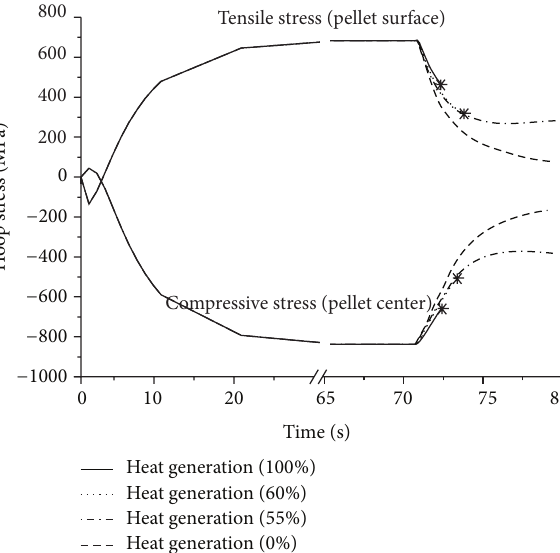
Figure 13: Compressive and tensile stresses changes at pellet center and outer surface after LOCA at